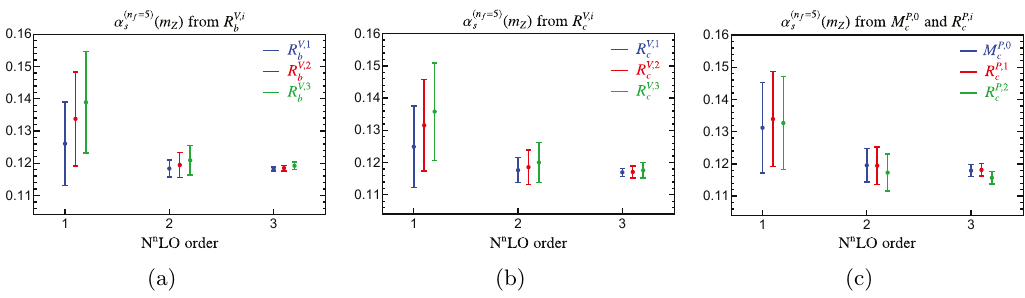
Figure 3 . (cid:11) ( n f =5) s ( m Z ) as determined from ratios of moments or M P; 0 using the corresponding per- c turbative series at O ( (cid:11) n ) with n = 1 ; 2 ; 3 which we call N n LO. Panels (a), (b), and (c) show results s for the bottom vector, charm vector, and charm pseudo-scalar correlators, respectively. For (a) and (b), blue, red and green correspond to R V; 1 , R V; 2 , and R V; 3 , respectively, with q = c; b , while for (c) q q q these colors correspond to M P; 0 , R P; 1 , and R V; 2 . Error bars re(cid:13)ect only perturbative c c c